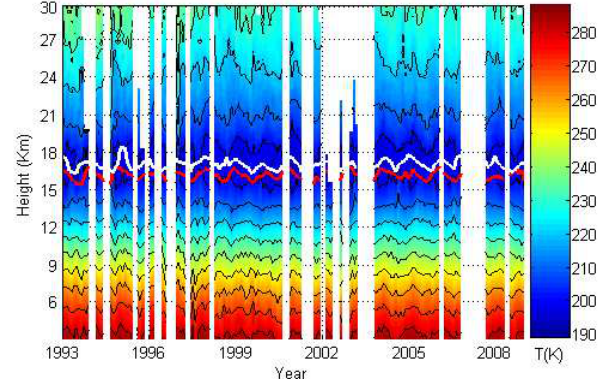
Figure 1: Evolution of the temperature time series from January 1993 to December 2008 over Reunion with CPT (white) and LRT (red). 6